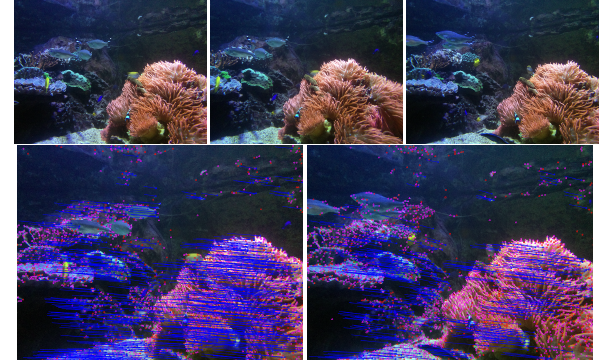
Figure 6. The experimental bench to finely measure the Figure 7. Example of matching result on a synchronised pair synchronisation rate of the acquisition: screen timer with a (left) and desynchronised pair (right) of a reef scene: we get two refresh time of 20ms and LEDs chaser with a refresh time of times more inliers for the synchronized pair than the 1ms. desynchronised pair. Most of the inliers of the desynchronised pair are on statics parts (coral and